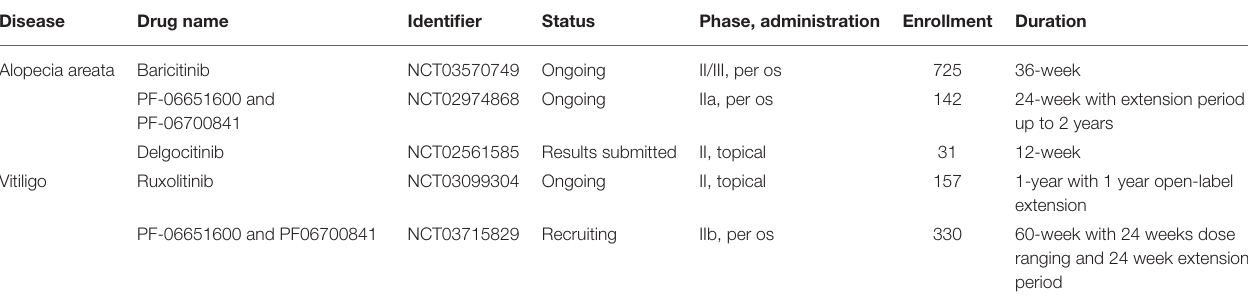
TABLE 5 | Phase II and III clinical trials studying Jak inhibitors in alopecia areata and vitiligo.